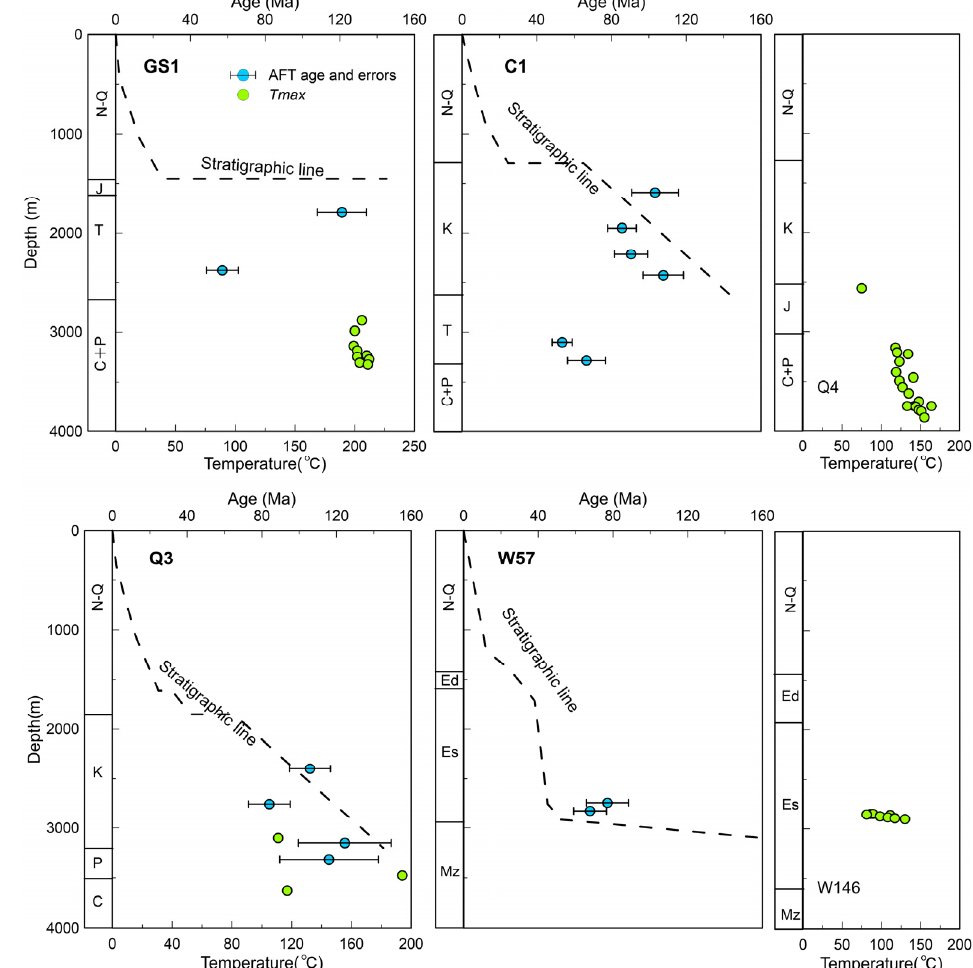
Figure 3. The relationship between the Tmax (maximum paleo-temperature)/AFT age and depth of the wells GS1, C1, Q3, and W57 in the Linqing Sub-basin. The Tmax of C1 and W57 refer to the Ro data from the close wells Q4 and W146, respectively. Carboniferous (C), Permain (P), Trassic (T), Jurassic (J), Cretaceous (K), Neogene (N), Quaternary (Q), Mesozoic (Mz), Shahejie formation (Es), Dongying formation (Ed).